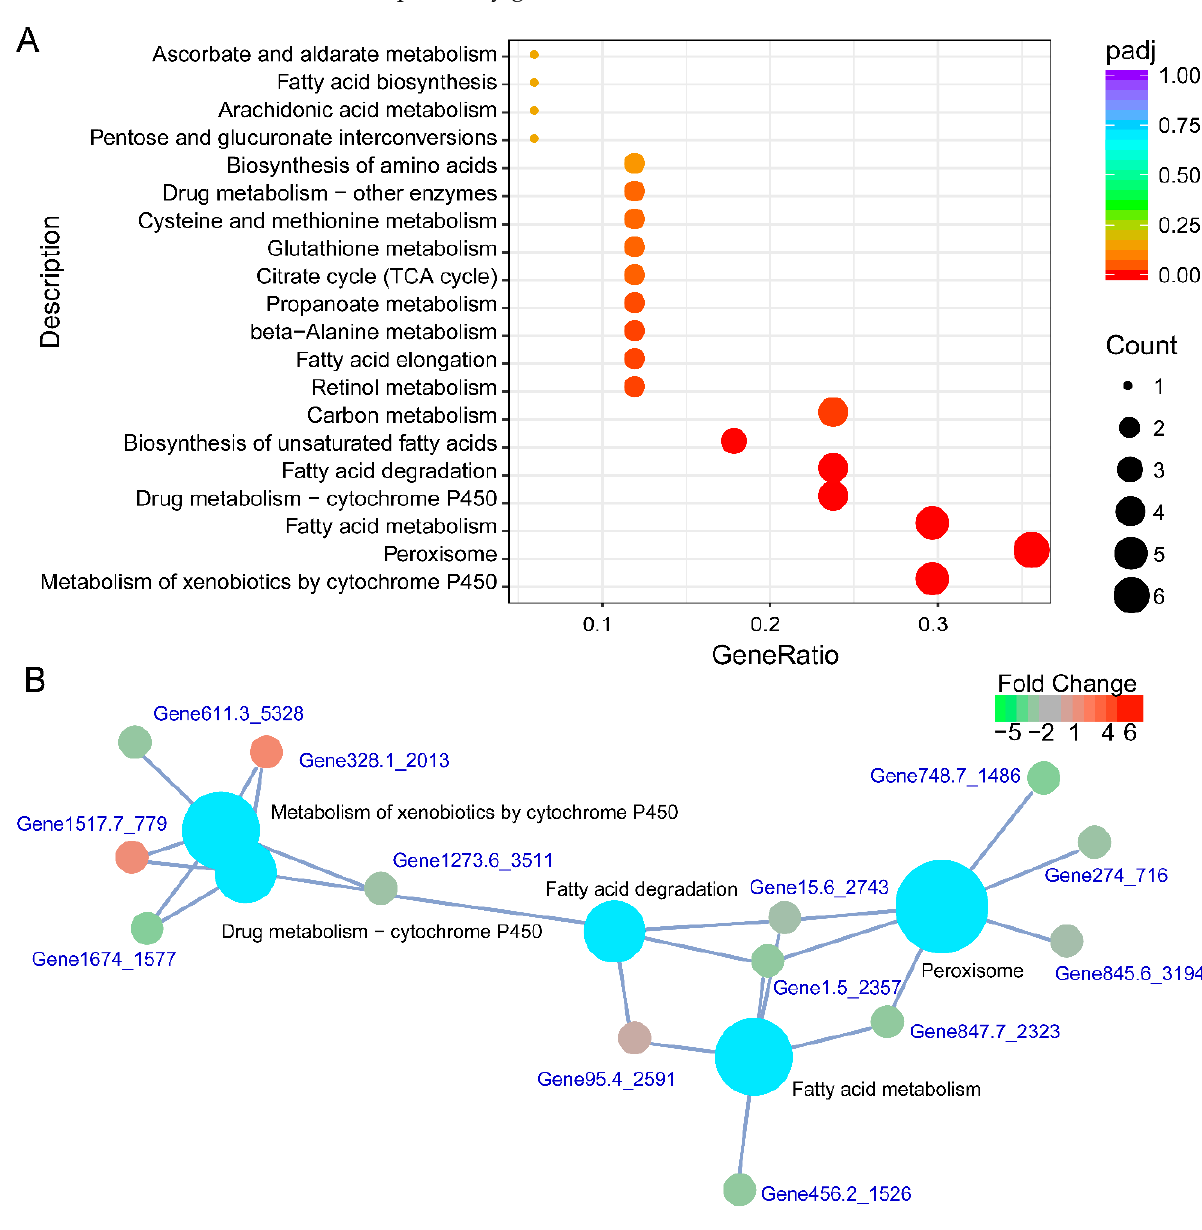
Figure 5. Kyoto Encyclopedia of Genes and Genomes (KEGG) enrichment of DEGs in dauer juveniles (J IV ) of Bursaphelenchus xylophilus promoted by β -pinene. ( A ) Scatter plots of KEGG term enrichment of DEGs in J IV promoted by β -pinene. X -axis indicates the ratio of the number of DEGs in this KEGG term/the number of total DEGs. Y -axis indicates the KEGG term. The size of the point means the number of DEGs in this KEGG term. The color, from red to purple, means the p -value of significance. ( B ) CNET plots of KEGG term enrichment of the DEGs in J IV promoted by β -pinene. The color, from green to red, means the fold change of the DEGs.